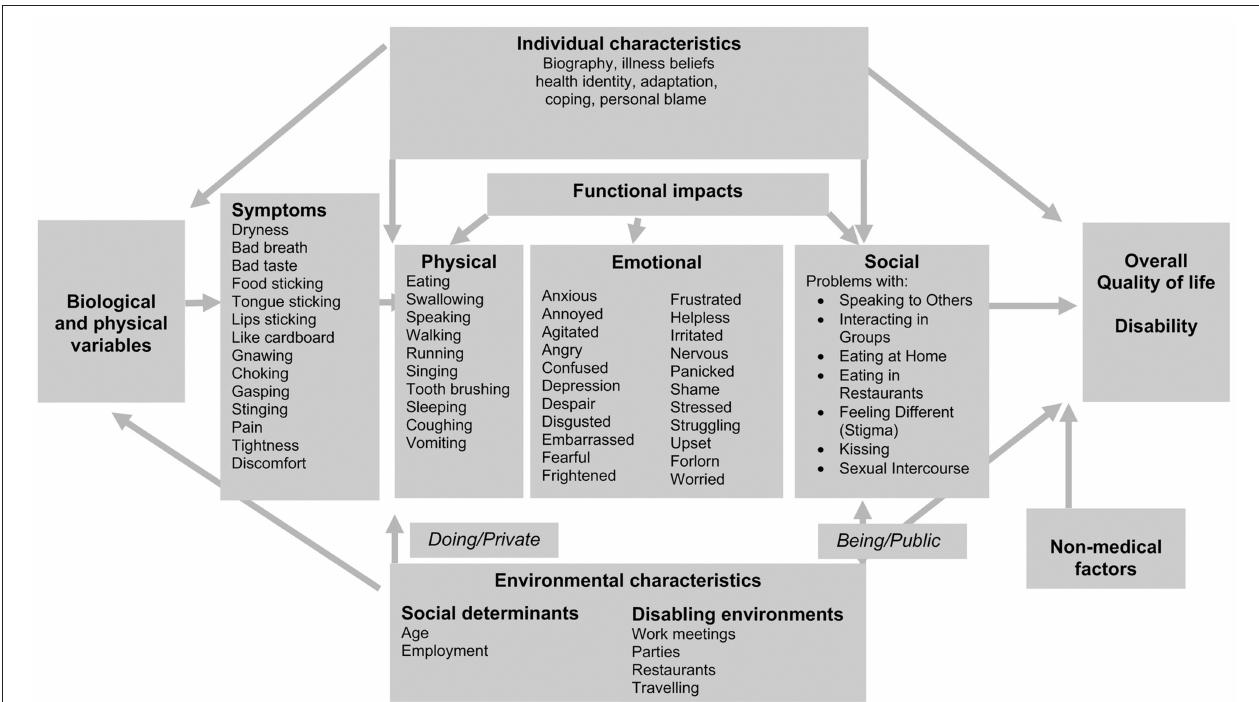
FIGURE 3 | Adapted from [17]: The interaction between personal and environmental characteristics and the impacts of dry mouth in association with the Wilson and Cleary model